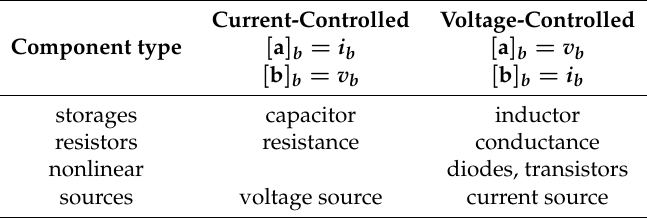
Table 2. Sorting components according to their